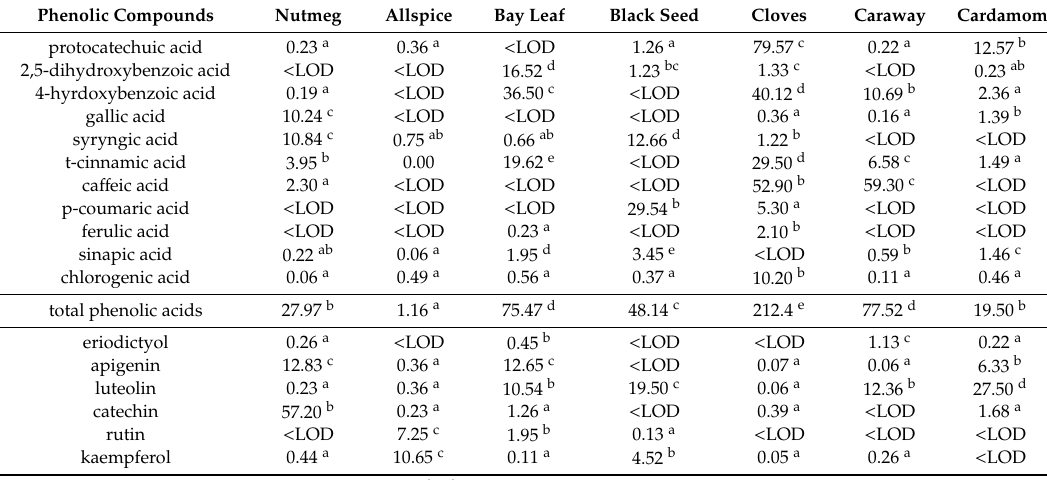
Table 2. UPLC analysis of phenolic compounds in spice extracts (mg / kg